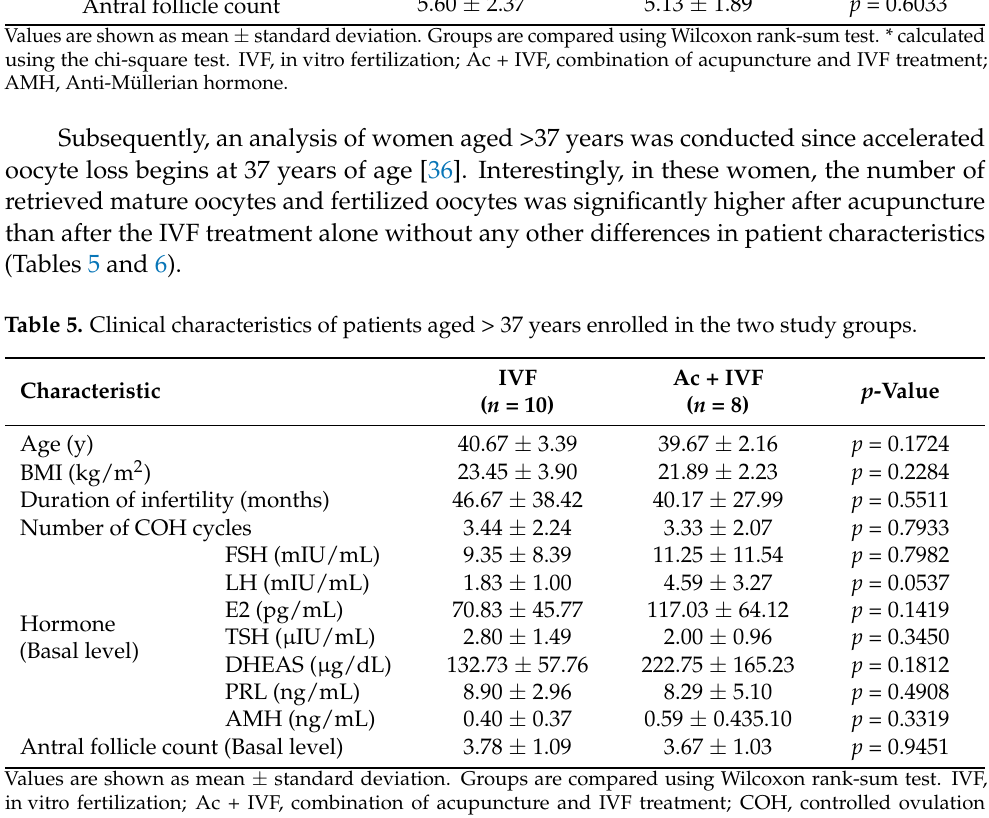
Fertilization rate *